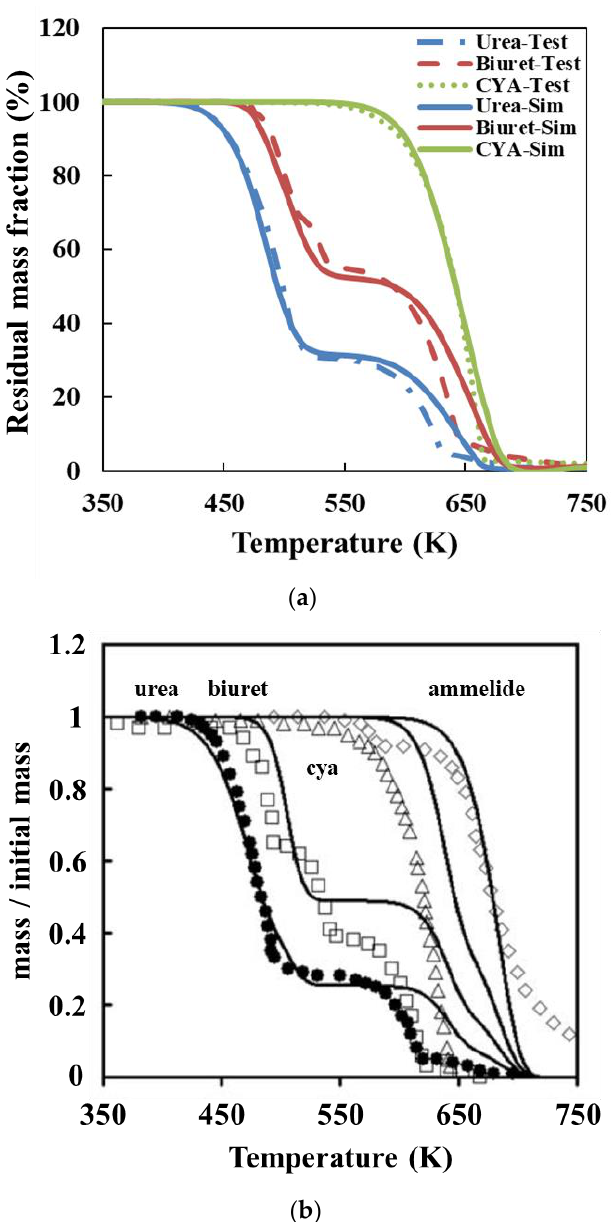
Figure 6. Comparison of the simulation and experiment results of the deposit reaction kinetic model ( a ) Model in this paper ( b ) Ebrahimian model. (Solid line-simulation, symbol-test).